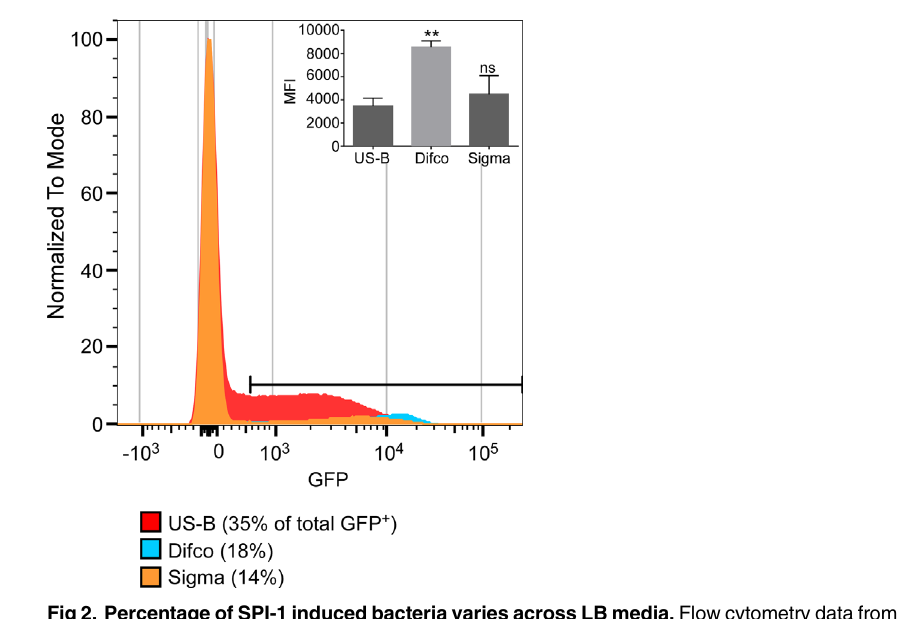
Fig 2. Percentage of SPI-1 induced bacteria varies across LB media. Flow cytometry data from a representative experiment showing GFP-intensity for the P prgH reporter strain grown in US Biological, Difco, or Sigma LB-Miller. Inset: MFI of gated GFP + bacteria for the P prgH reporter strain. Data shown are mean ± SD, n = 3. Statistical analysis was done using a one-way ANOVA with Dunnett ’ s multiple comparisons test ( * p <